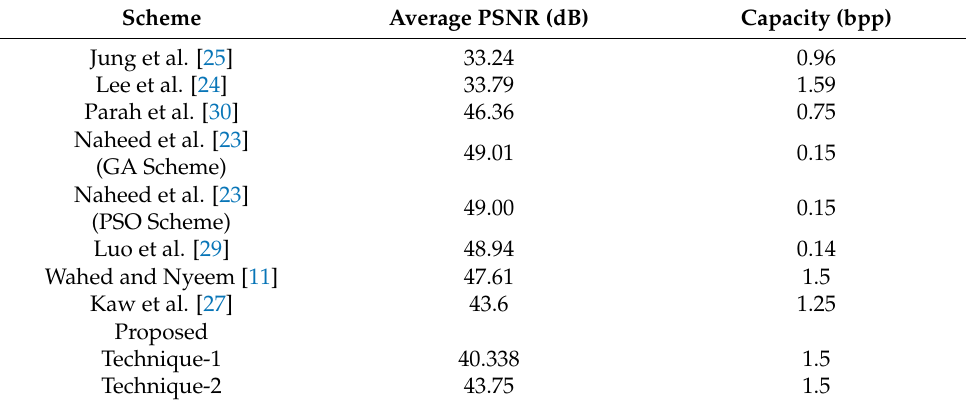
Table 2. Comparison to state-of-the-art